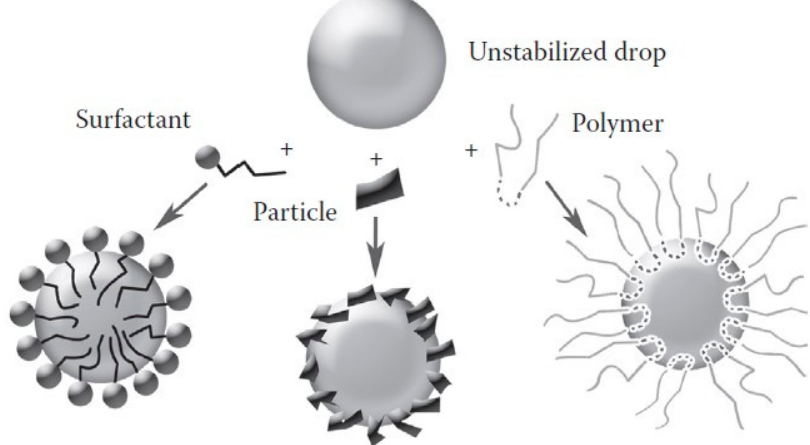
Figure 2. Interfacial stabilizing layers formed by surfactants, particles and polymers. Differences in scaling are not considered. Adapted with permission from [15]. Copyright CRC Press, Taylor and Francis Group.